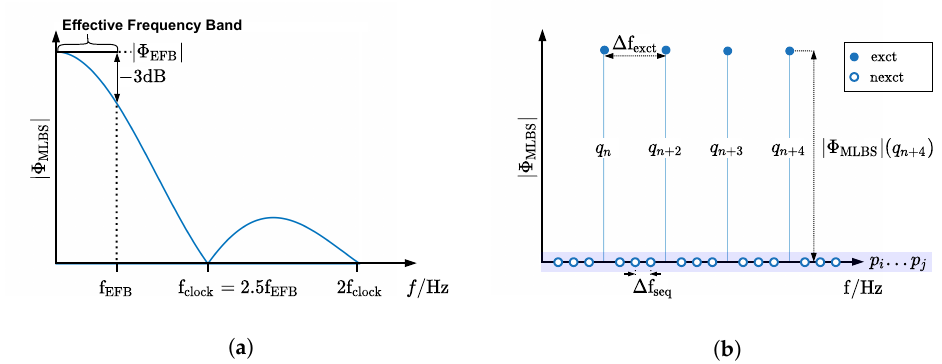
Figure 5. Spectrum of harmonic distortion current i harm . ( a ) Spectrum of i harm in abc domain. ( b ) Spectrum of i harm in dq